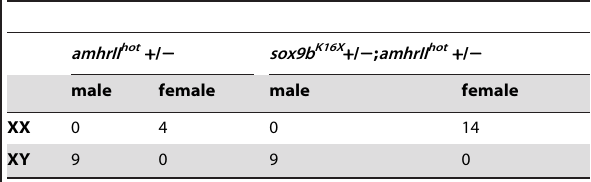
Table 3. Female to male sex reversal phenotype is rescued in sox9b and hotei compound heterozygous